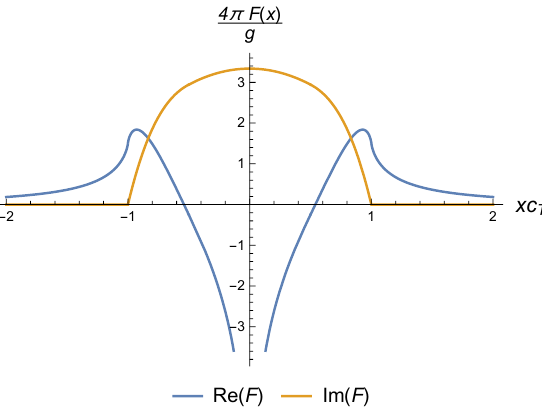
Figure 5. Real and Imaginary parts of the function F , which determines the self-energy of the dislons through Π = m ω 2 F in the isotropic case. They do not vanish simultaneously. The plots were generated setting γ =